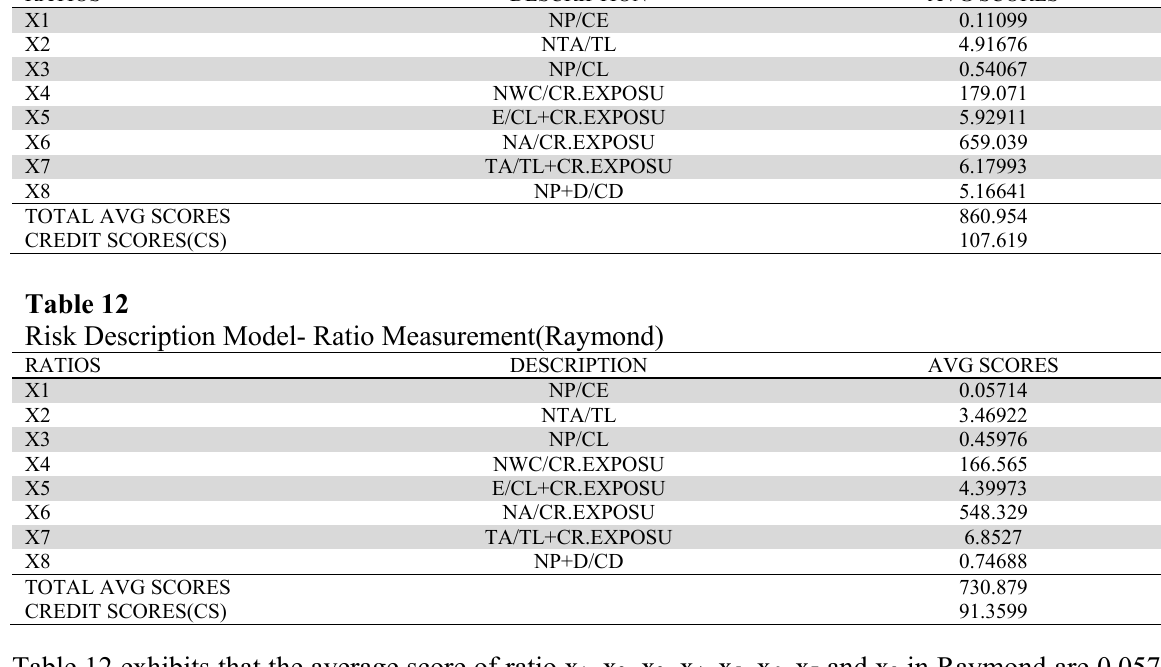
Risk Description Model – Ratio Measurement (Gini Fabrics) RATIOS